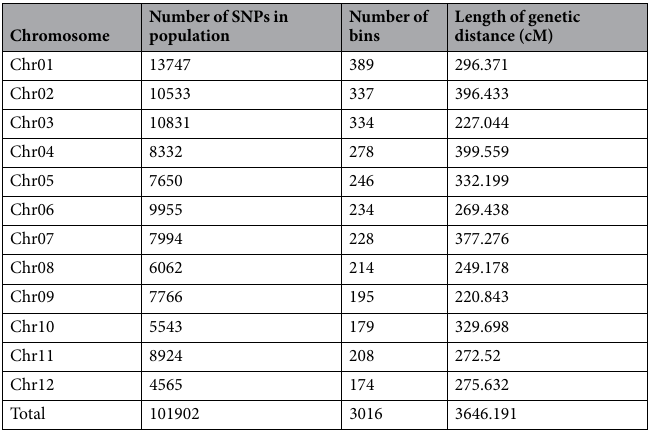
Table 1. Number of SNPs and bins per chromosome in the R998 × Francis RILs